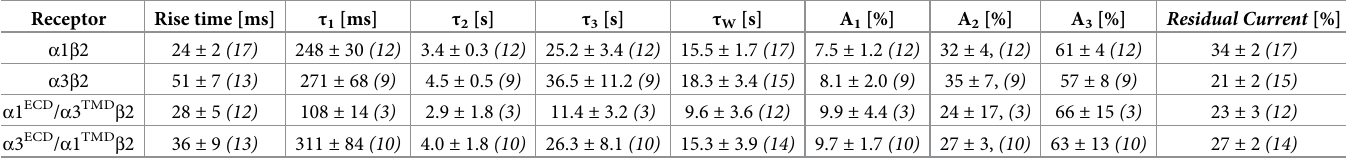
The number of experiments (n) is given in italics in parenthesis for each